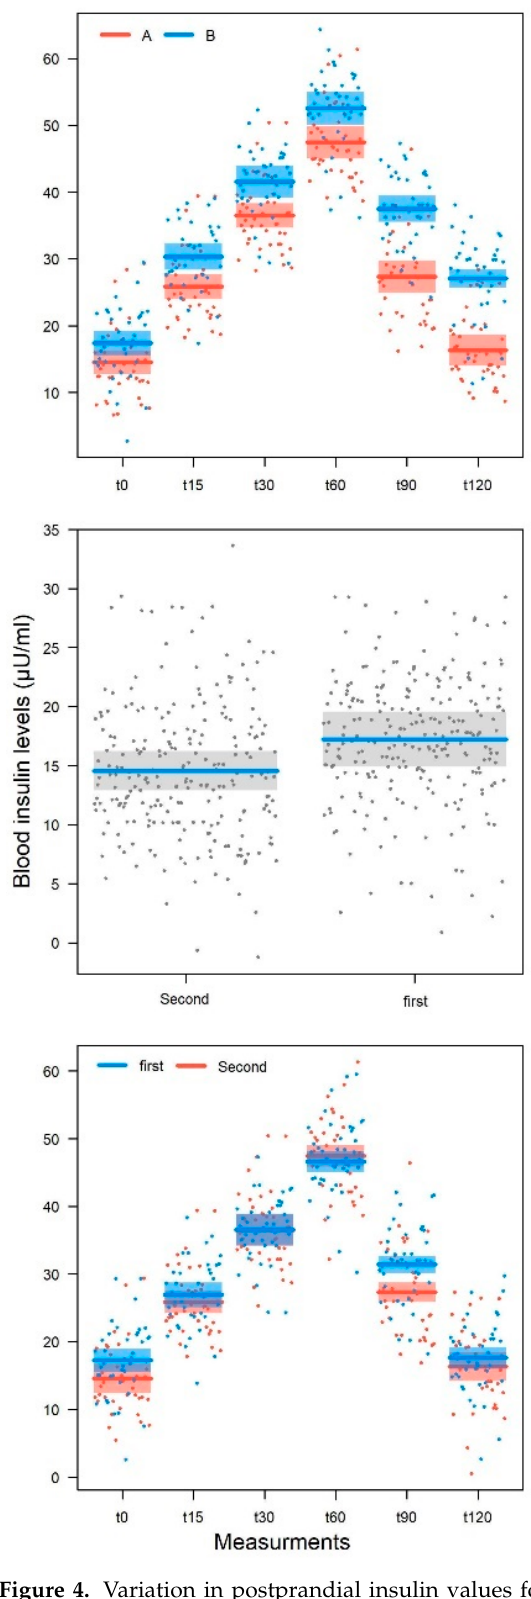
Figure 4. Variation in postprandial insulin values for the two experimental treatments. Above : variation of the insulin concentration for the two experimental treatments (A: BSG extract-based food supplement, and B: placebo); middle : insulin concentration values before and after washout; bottom : change in insulin concentration before and after washout regardless of experimental